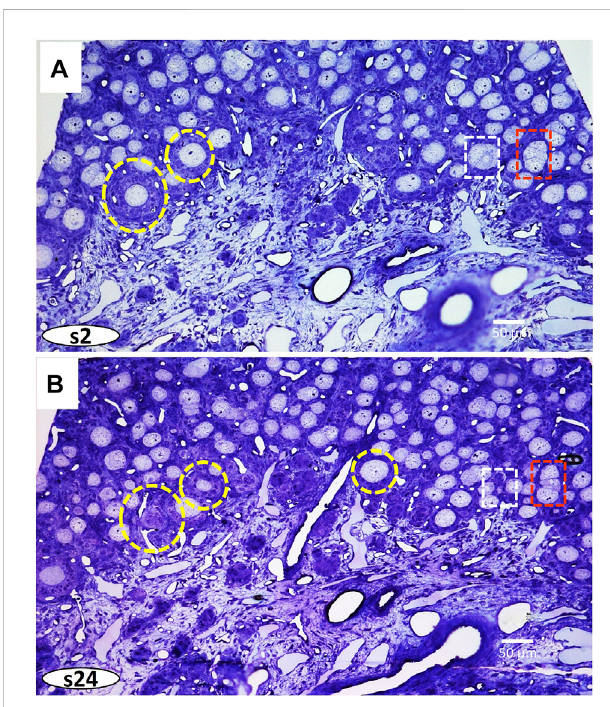
FIGURE 3 Two images of semithin sections (1.0 µm) at different levels: (A) section two (s2), and (B) section twenty-four (s24), were taken from Supplementary Movie S1 (Supplementary Material). Dashed circles and squares correspond to Follicles and cysts, respectively. Follicles represent individual oocytes enveloped within follicular cells. Ovarian cysts are formed by clusters of oocytes at different stages of fusing within the ovigerous cords.